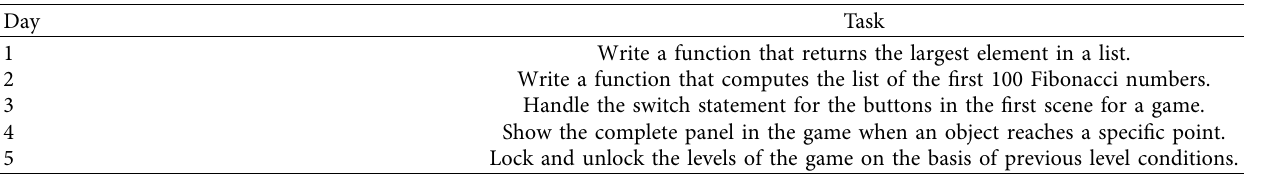
Table 1: Developers’ daily